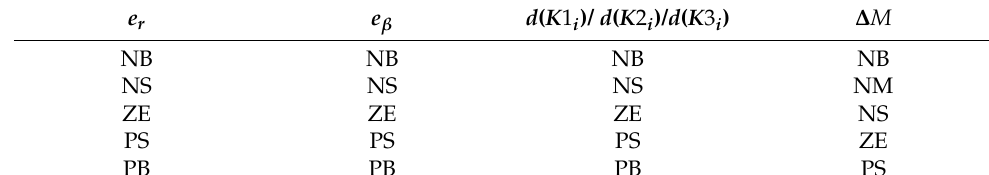
Table 2. Fuzzy set partition table.